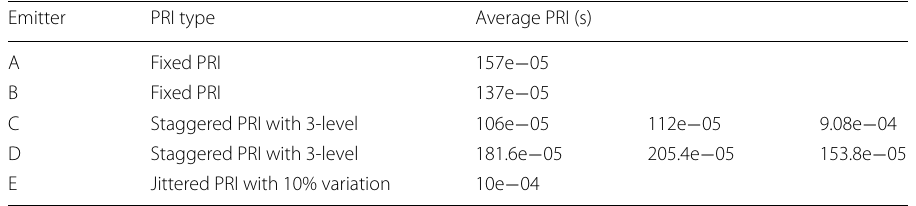
Table 1 Values and type of PRI of the pulses sequence received from emitters